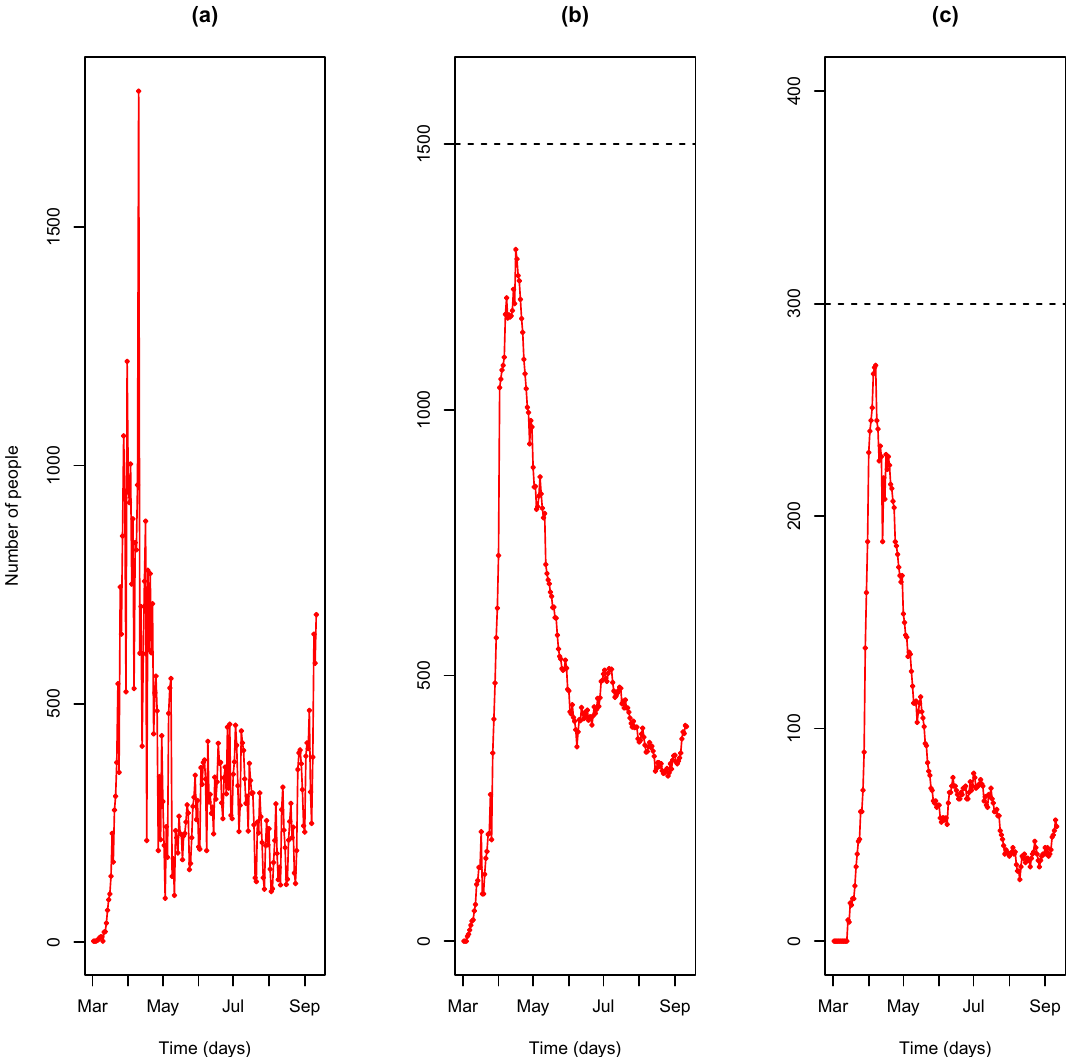
Figure 1. Course of the COVID-19 epidemic in Portugal. ( a ) Daily incidence of COVID-19 cases in Portugal, ( b ) Daily hospital occupancy due to COVID-19 in Portugal, ( c ) Daily ICU occupancy due to COVID-19 in Portugal. Data collected from the daily bulletins issued by Direção-Geral de Saúde (Directorate-General of Health, DGS), the Portuguese health authority. The dashed horizontal lines show the generally accepted national health system